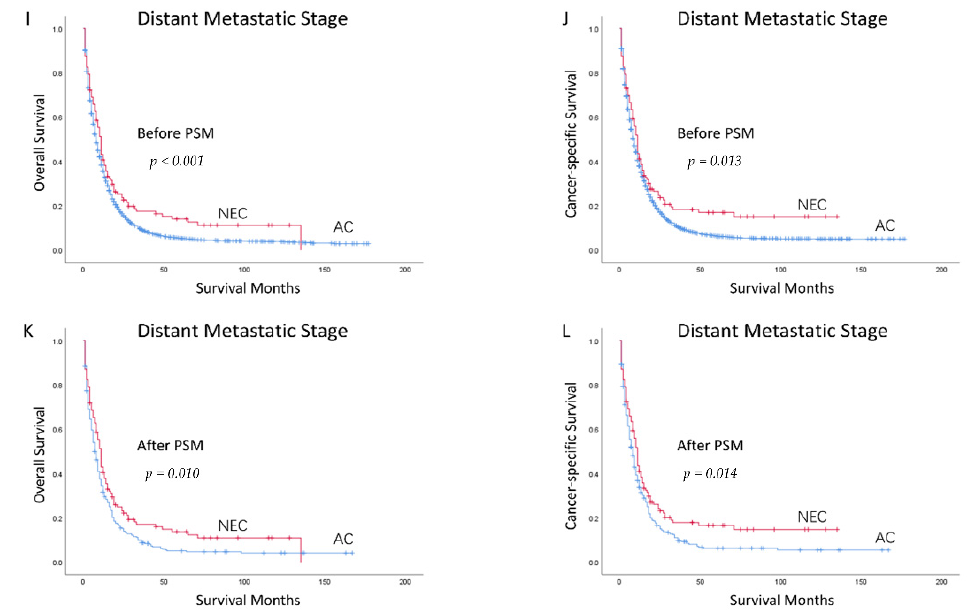
Figure 2. Kaplan–Meier Survival Curves for White Patients with Different Stage Gastric Neuroen- docrine Carcinoma and Adenocarcinoma before and after PSM (Early Stage before PSM: ( A ): OS, ( B ): CSS; Early Stage after PSM: ( C ): OS, ( D ): CSS; Locally Advanced Stage before PSM: ( E ):